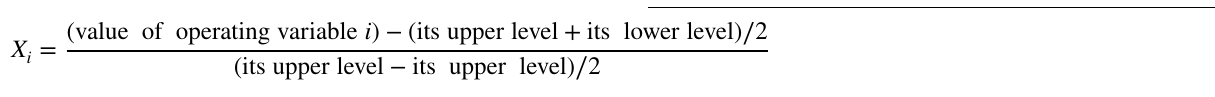
Table 3 Experimental and predicted achieved removal responses for RSM after 30 min of reaction time